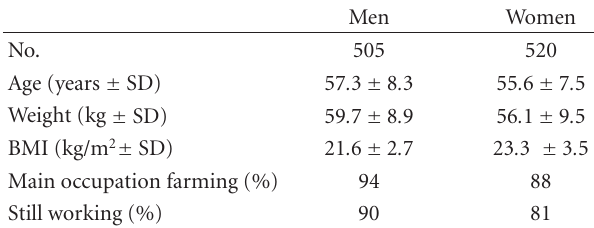
Table 1: Characteristics of the Wuchuan County study participants.